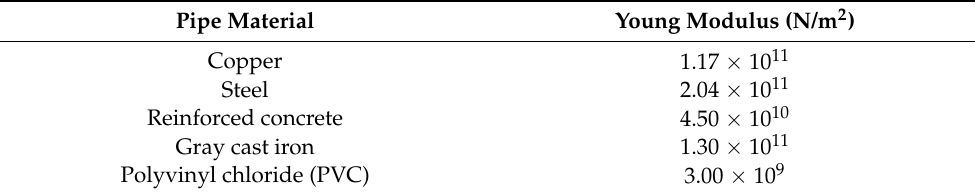
Table 4. Young modulus properties of